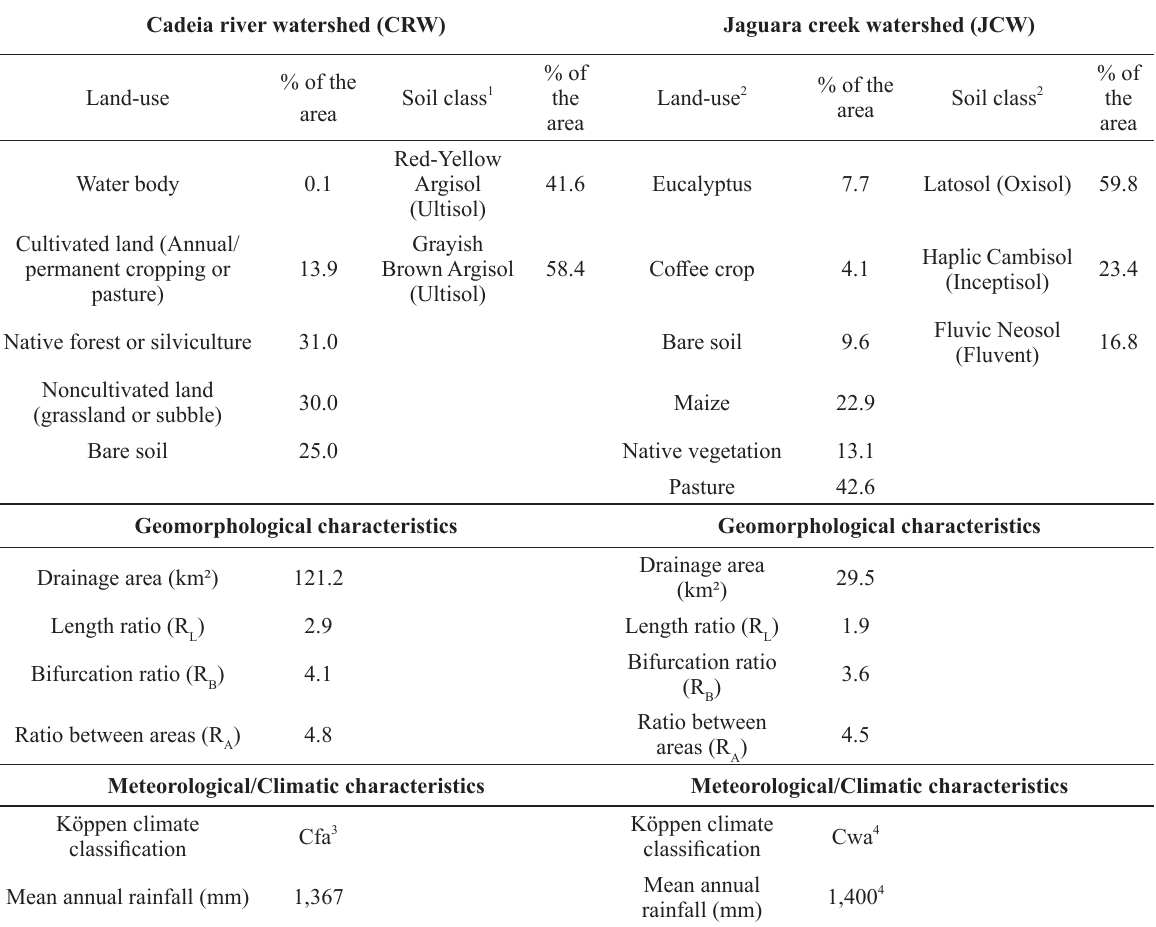
Land-use and soil classes and geomorphological and meteorological/climatic characterization of Cadeia river watershed (CRW) and Jaguara creek watershed